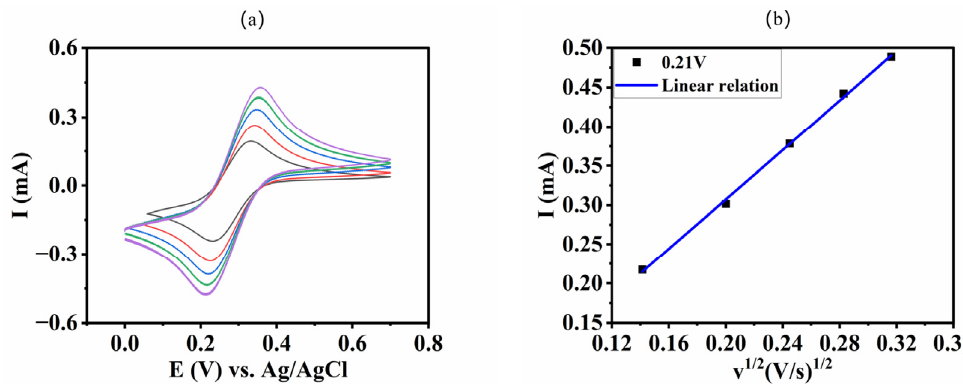
Figure 5. CVs of ITO/(Cu 4 P 4 W 30 /PDDA-GO) 6 in 1.0 mM [Fe(CN) 6 ] 3 − /4 − solution containing 0.1 M KCl at different scan rates (20, 40, 60, 80, and 100 mV · s − 1 ) ( a ) and the linear relationship between the oxidation peak currents and the square root of scan rates ( b ).The black square corresponds the current per square root of scan rates and the blue line corresponds the fitted linear relationship.